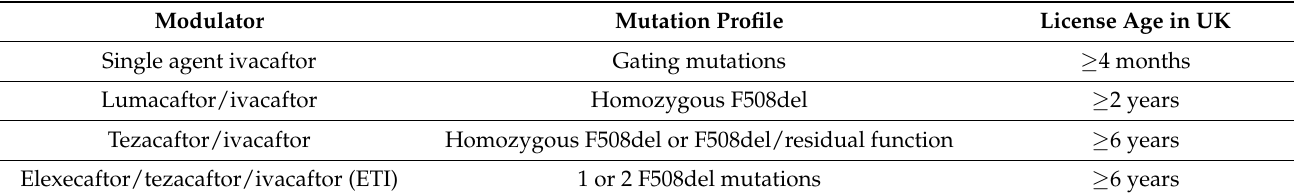
Table 1. Summary of licensed modulator